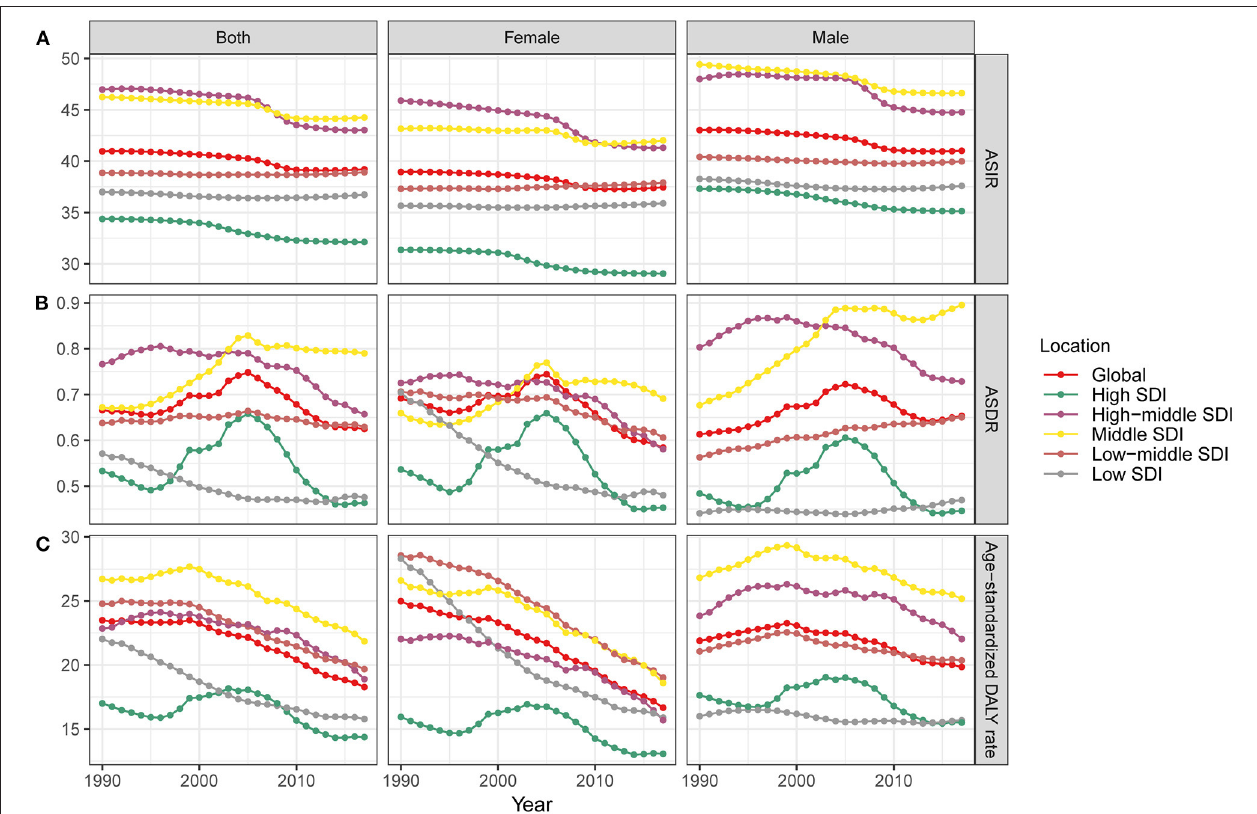
FIGURE 3 | The trends of ASIR change (A) , ASDR (B) , and age-standardized DALY rate (C) (per 100,000 persons) globally and among different SDI quintiles between 1990 and 2017. ASIR, age-standardized incidence rate; ASDR, age-standardized death rate; DALY, disability-adjusted life year; SDI, Socio-Demographic Index.